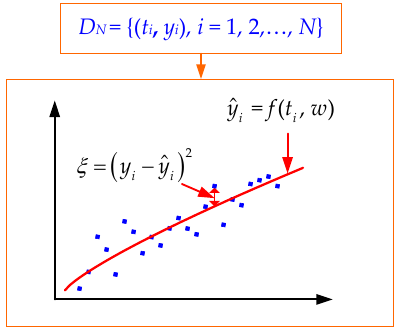
Figure 6. The illustration of linear regression.